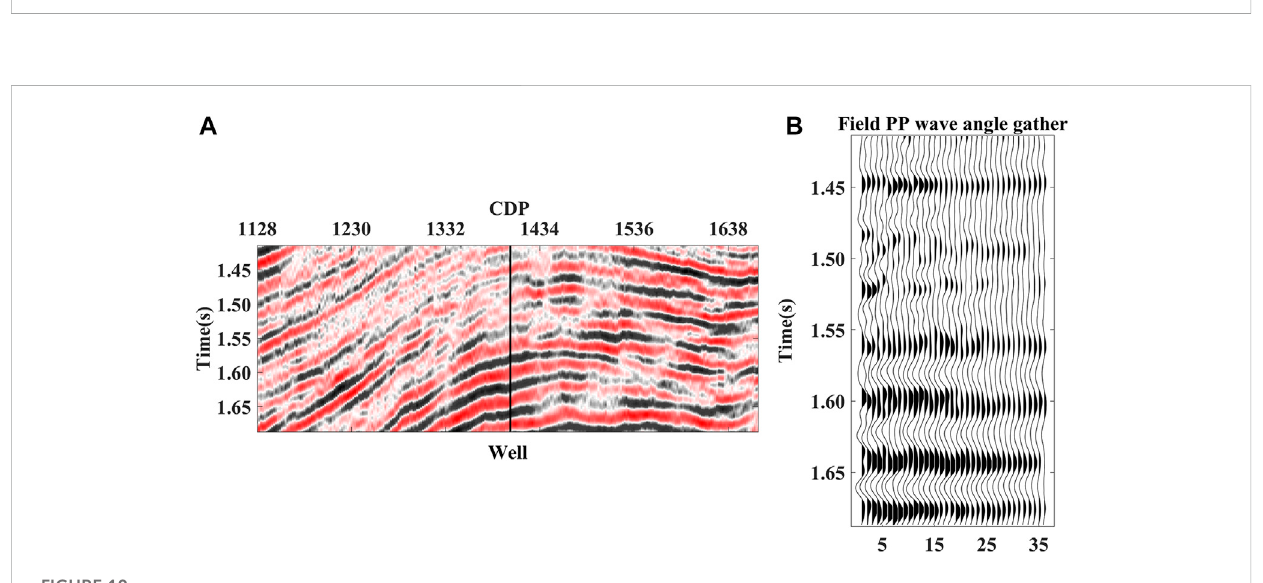
FIGURE 9 Analysis of (A) the mr error and (B) CCs between the true models and the inversion results of Young ’ s modulus (red), Poisson ’ s ratio (blue), and density (green) based on the newly rewritten Zoeppritz equation (solid lines), the YPD approximation (dotted lines with squares), and the non-linear YPD equation (dotted lines with triangles) with the white noise of